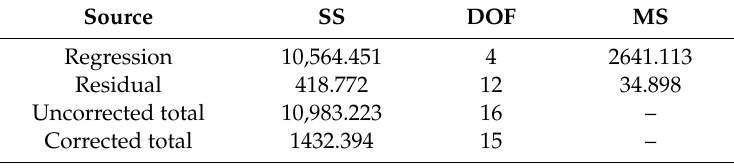
Table 5. ANOVA for the power function model of α Y